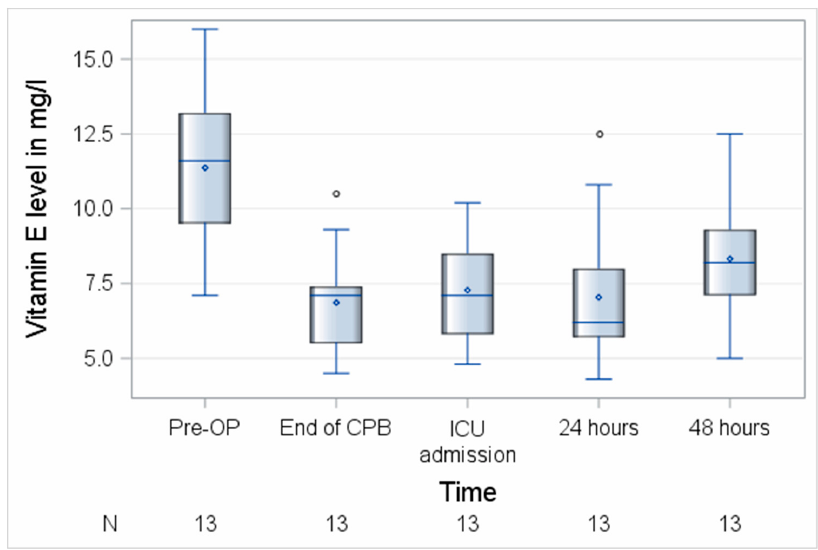
Figure 2. Perioperative course of vitamin E. CPB, cardiopulmonary bypass; ICU, intensive care unit; N, number of patients. Circles represent outliers.